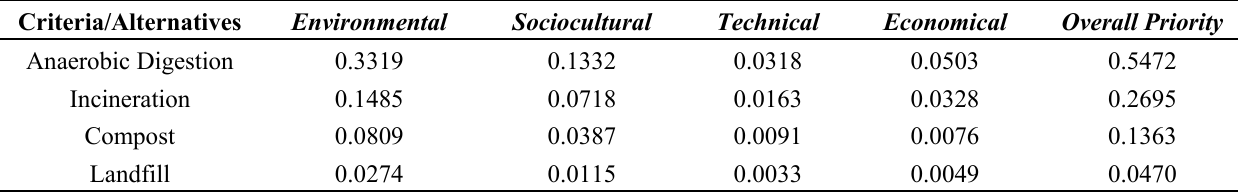
Table 8. Composite weight for all criteria: synthesizing to obtain the final